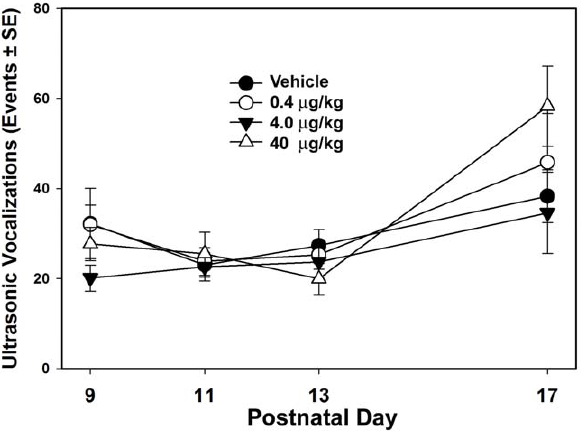
Figure 2. Number of bouts of ultrasonic vocalizations (USV) on postnatal days 9, 11 13 & 17. No group differences were statistically